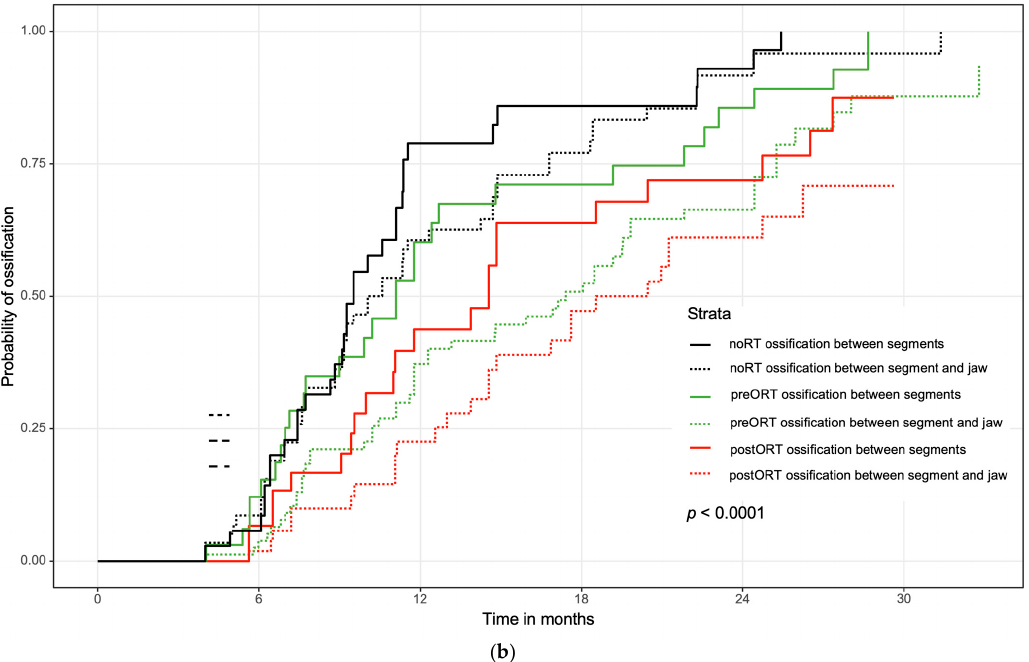
Figure 3. ( a ) Ossification concerning the contact between two segments of the transplant and between one segment of the transplant and the original bone of the jaw. ( b ) Ossification concerning the contact between two segments of the transplant and between one segment of the transplant and the original bone, subdivided regarding time and event of radiation therapy. Bone healing was faster between graft segments compared to segment/jaw contacts in both preORT and postORT groups.